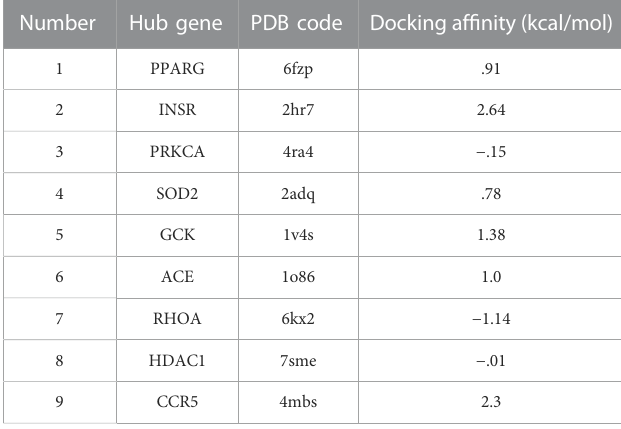
TABLE 2 Results of 9 hub genes and Forsythiaside molecular